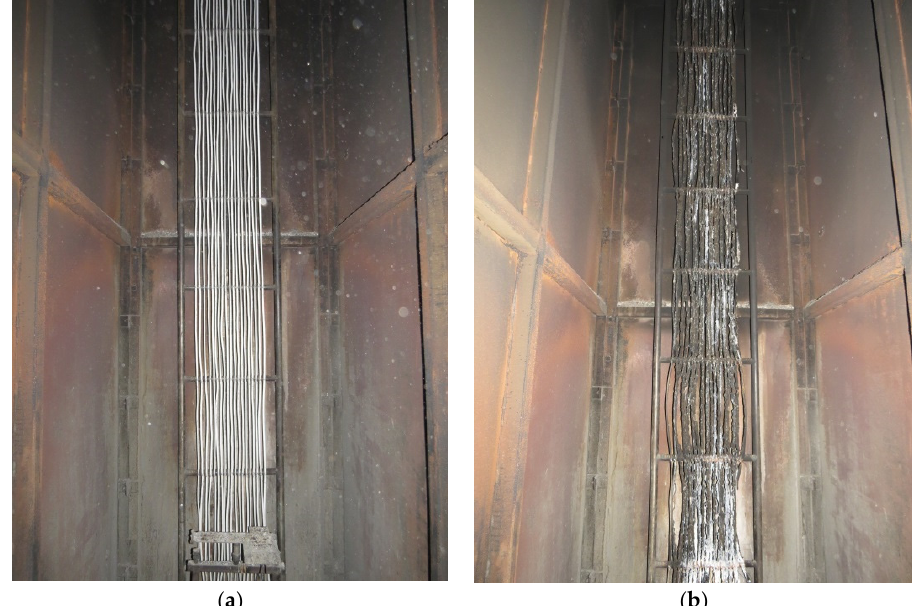
Figure 11. PVC-insulated and sheathed coaxial cable on the test ladder according to EN 50399 standard: ( a ) before the test, ( b ) after the test.